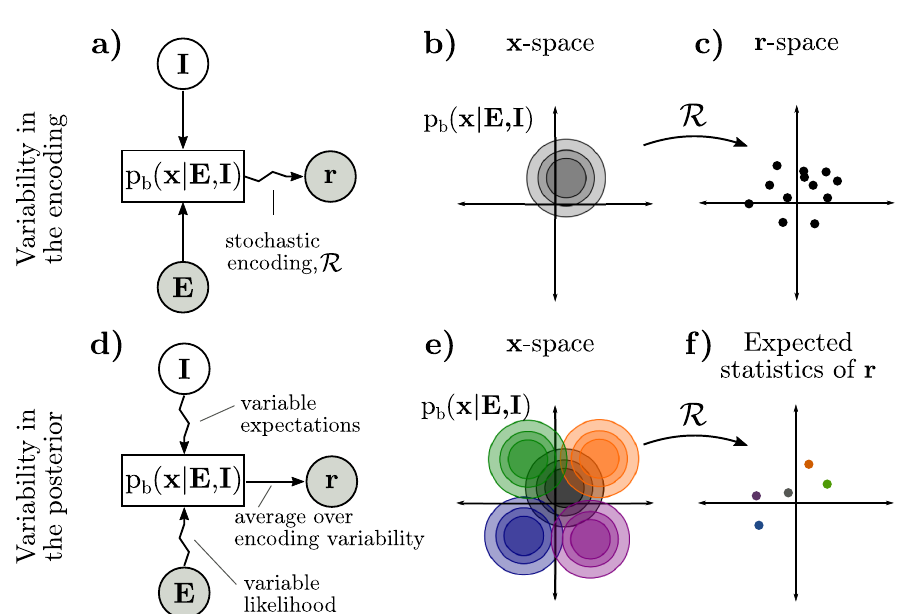
Fig 2. Two distinct sources of neural co-variability in the Bayesian inference framework: Stochastic encoding of a fixed posterior (a-c) and variability in the posterior itself (d-f). a) Consider the case where there is no variability in I or E and inference is exact (indicated by straight arrows from E and I to p b ), but posteriors are noisily realized in neural responses r (indicated by a zigzag arrow from p b to r ). b) Exact inference always produces the same posterior for x for fixed E and I . c) The neural encoding of a given distribution may be stochastic, so a single posterior (b) becomes a distribution over neural responses r . The shape of this distribution may or may not relate to the shape of the posterior in (b), depending on the encoding (e.g. there is a correspondence in sampling, but not in parametric codes). d) Both sensory noise and variable expectations induce trial-to-trial variability in the posterior itself (indicated by zigzag arrows from E and I to p b ). This variability in the encoded posterior adds to variability in the encoding, as in (a- c), and can be understood as affecting the average or expected neural responses (indicated by a straight arrow from p b to r ). e) Variability in the posterior can be thought of as a distribution of possible posteriors. f) Each individual posterior in (e) is a point in the space of expected statistics of r , such as expected spike counts. Variability in the underlying posterior may appear as correlated variability in spike